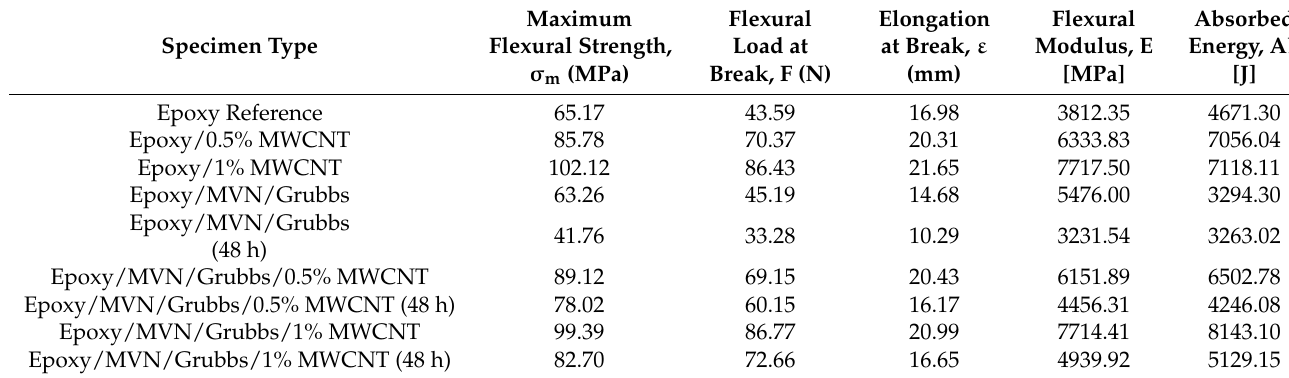
Table 4. Average results for the three-point bending tested specimens.